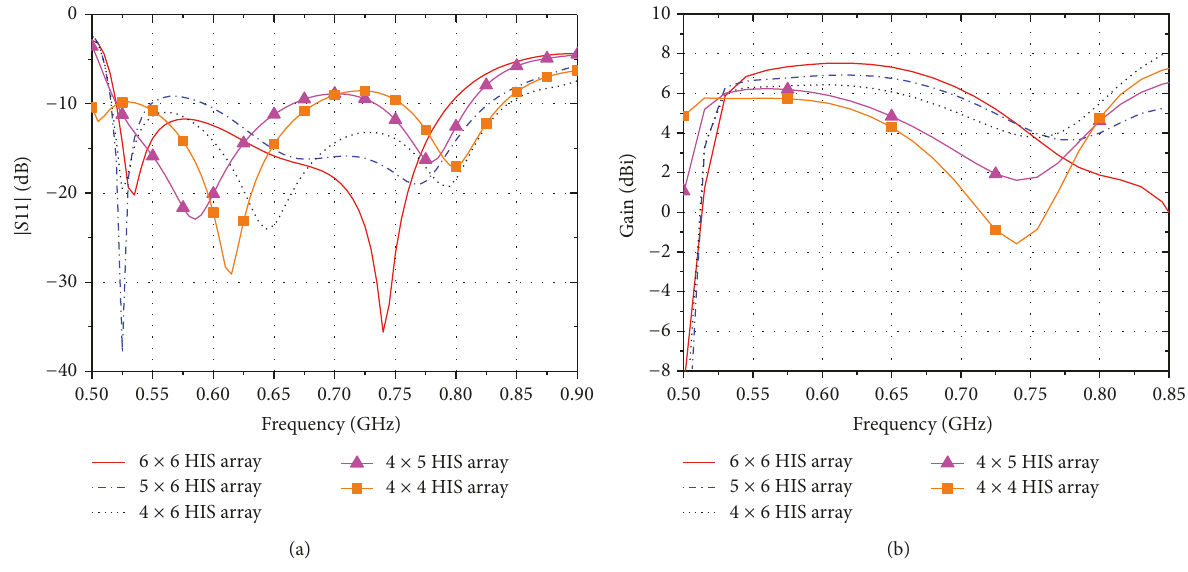
Figure 6: The effect of HIS array size to the antenna: (a) impedance matching and (b)